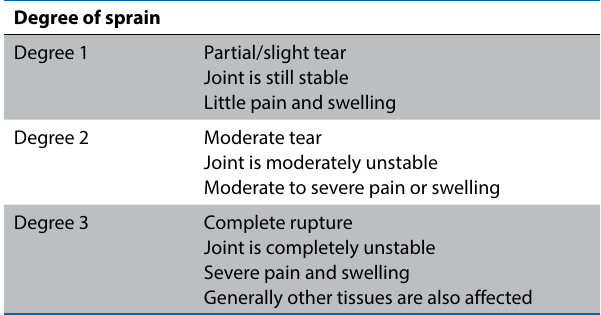
Table 2: Classification of sprains